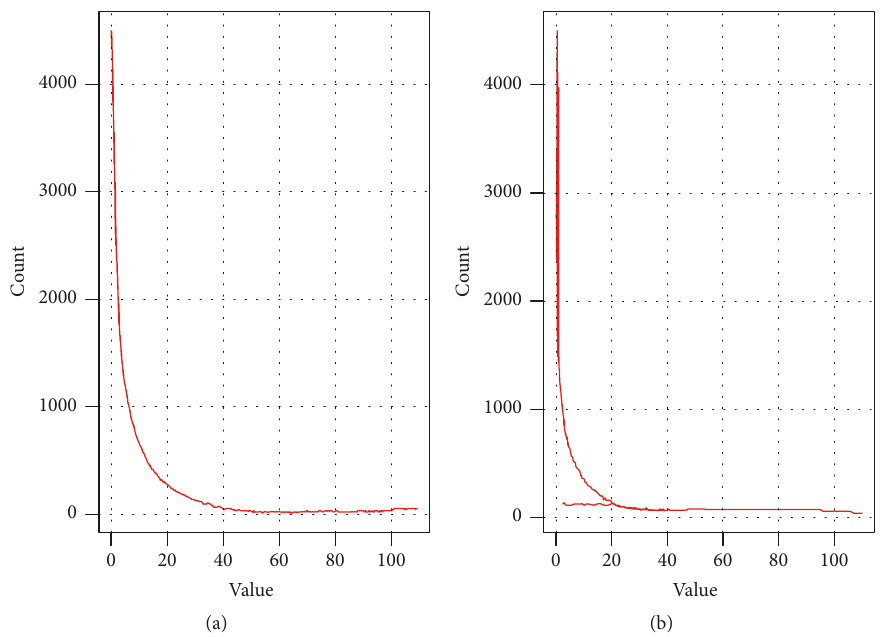
Figure 4: (a) is the outdegree distribution and (b) is the degree distribution.